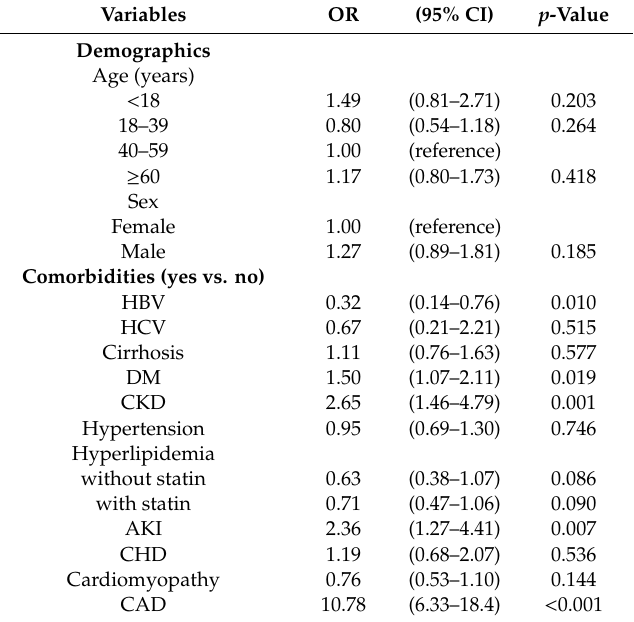
Table 4. Multivariate logistic regression analysis of risk factors associated with dialysis (non-dialysis vs. dialysis).